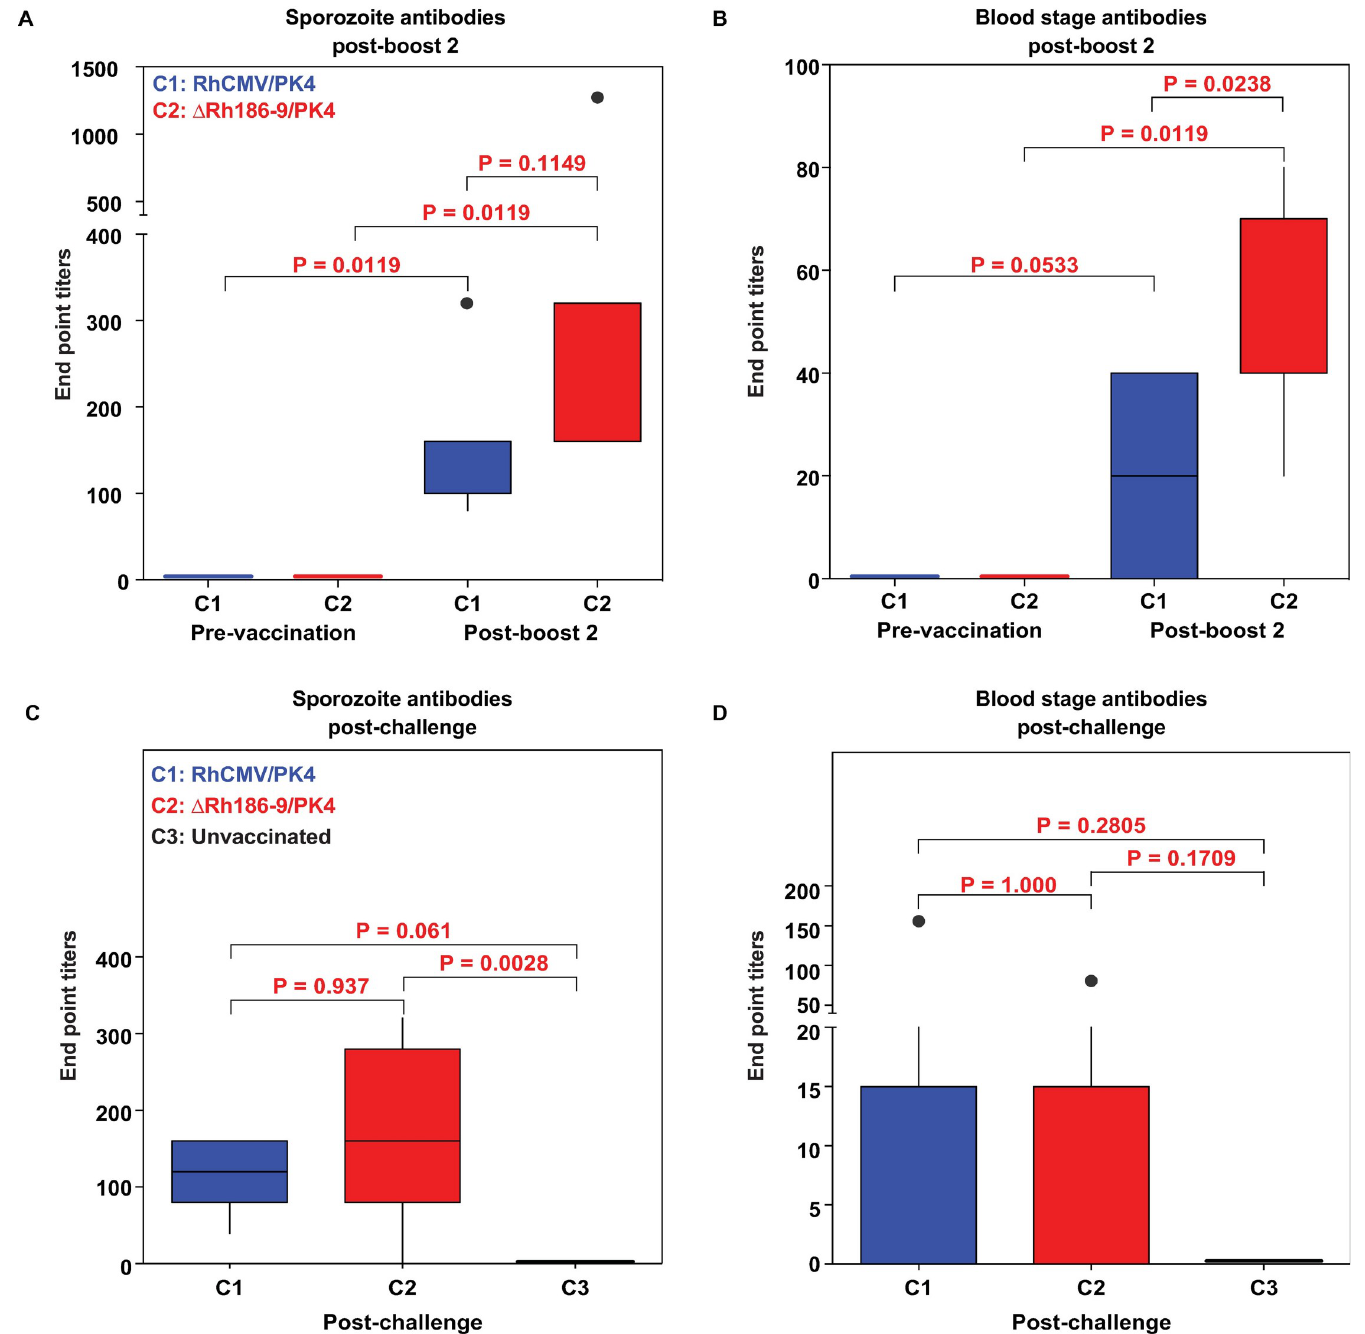
Fig 6. Antibody responses to P . knowlesi sporozoites and blood stage parasites. ( A, B) Endpoint titers of IgG antibodies in serum collected from cohort 1 (RhCMV/ PK4) or cohort 2 ( Δ Rh186-9/PK4) prior to immunization on day 0 or on day 203 (post-2 nd boost). Pk parasite stage-specific antibodies were measured by IFA to Pk Spz (A) and to Pk-infected RBC (B). (C, D) Endpoint titers to Spz (C) and blood stage parasites (D) determined by IFA at day 14 post-challenge for each animal in the indicated cohorts. Statistical significance for differences in Spz or blood stage antibody titers measured by IFA was determined using the Wilcoxon test. Unadjusted Wilcoxon test p-values comparing IFA results across groups are displayed as boxplots showing the median (horizontal line), interquartile range (box), and range (whiskers and outlier points).